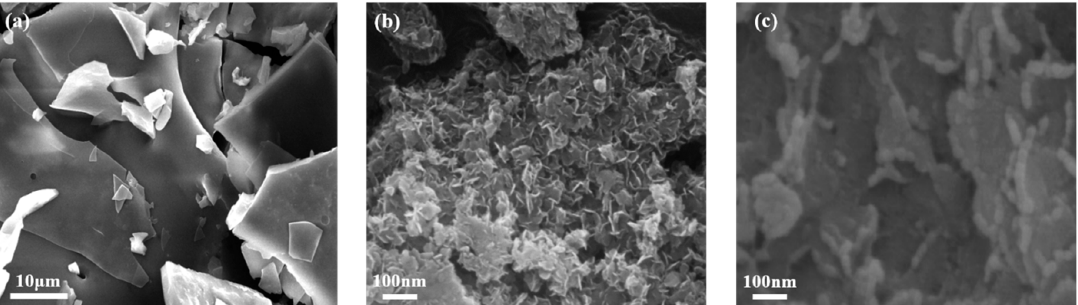
Figure 3. Scanning electron microscope image of ( a ) Zingiber officinale extract (ZOE), ( b ) Zingiber officinale extract–layered double hydroxide (ZOE–LDH) hybrid, and ( c ) magnified ZOE–LDH hybrid.